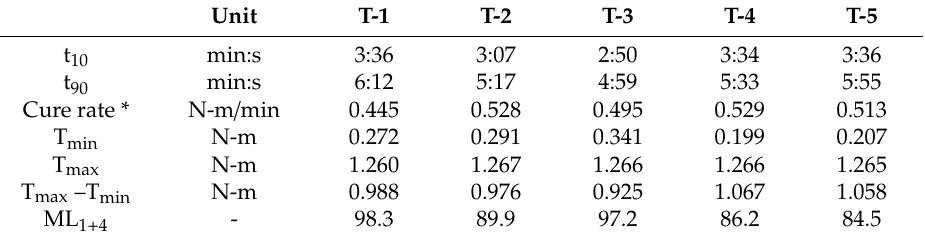
Figure 7. ( a ) The moving die rheometer (MDR) data for dry masterbatch (DMB) and WMB with SCAs. ( b ) The stress–strain curve of samples T-1–T-5. Table 4. The vulcanization reaction characteristics of silica/SBR composites.